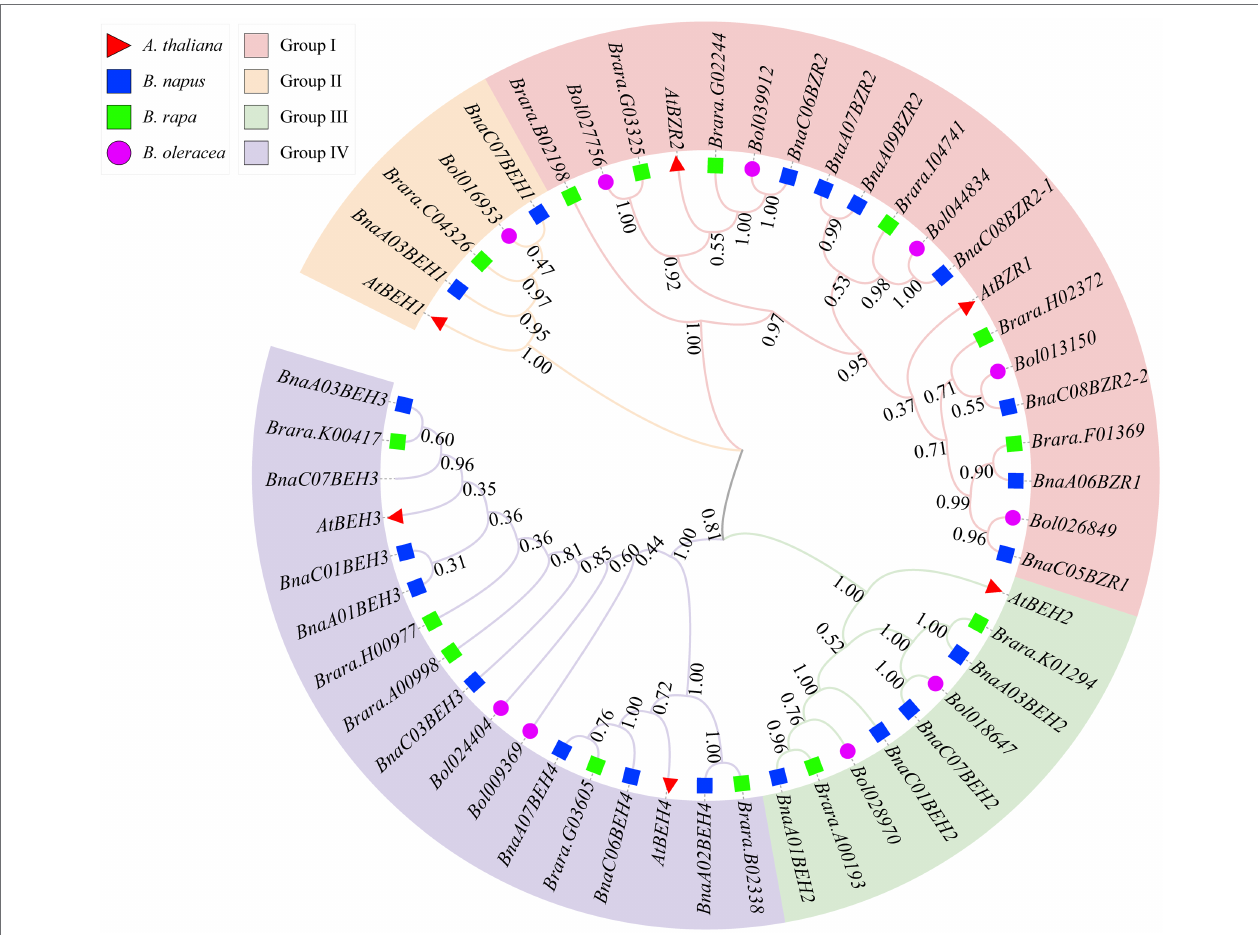
FIGURE 1 | Phylogenetic relationship of the BZR gene family from Brassica napus ( Bna ), Arabidopsis thaliana ( At ), B. rapa ( Bra ), and B. oleracea ( Bol ). Neighbor- joining (NJ) tree was constructed using the MEGA X with 1,000 bootstrap replication and visualized using online tool iTOL. Members in the BZR gene family clustered into the four groups and specified with different